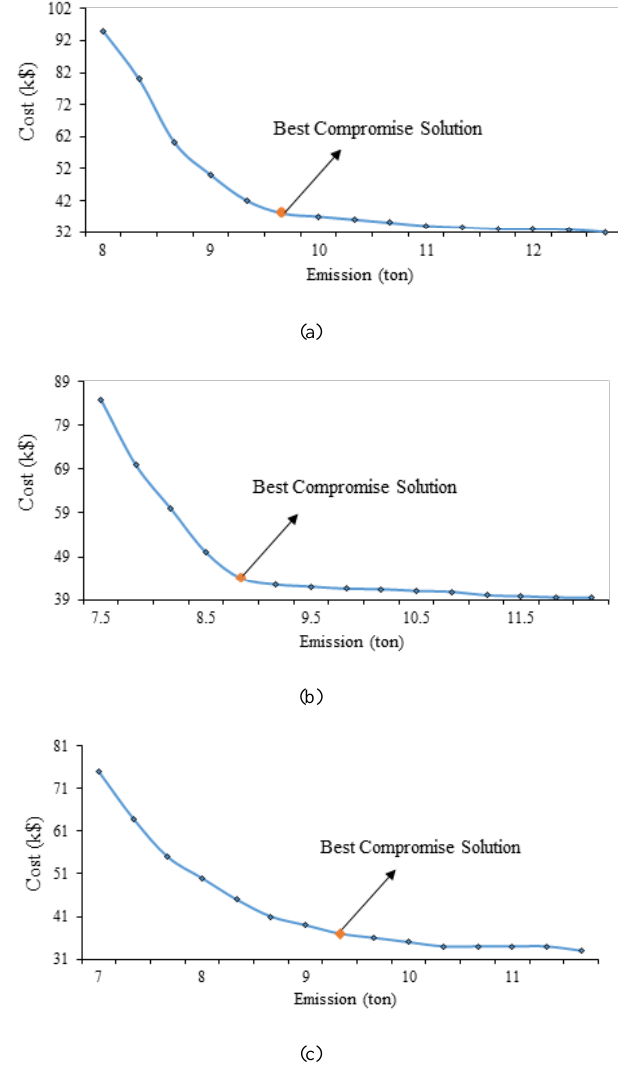
Fig. 5. The best compromise solution determined by fuzzy decision-making process in Pareto-optimal front. a) first case; b) second case; c) third